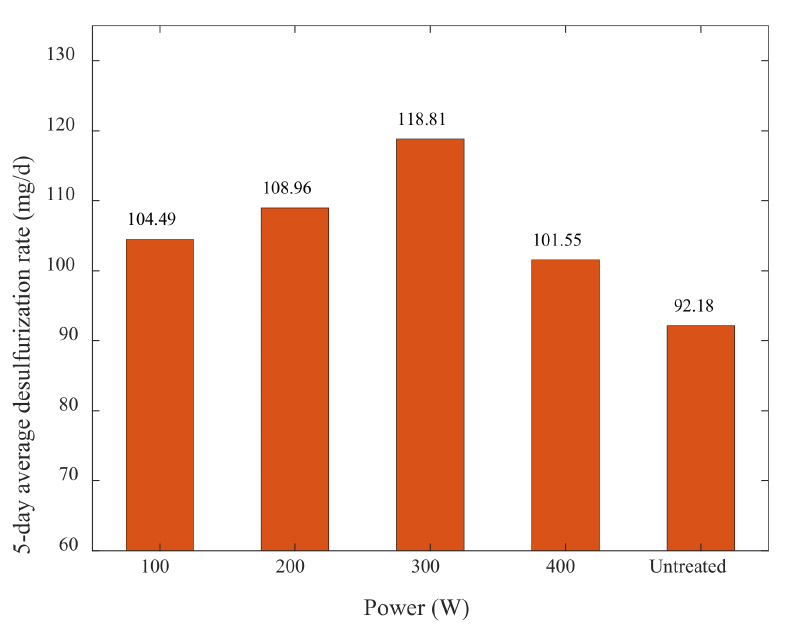
Figure 10. Comparison of the 5-day average desulfurization rate of different ultrasonic power.